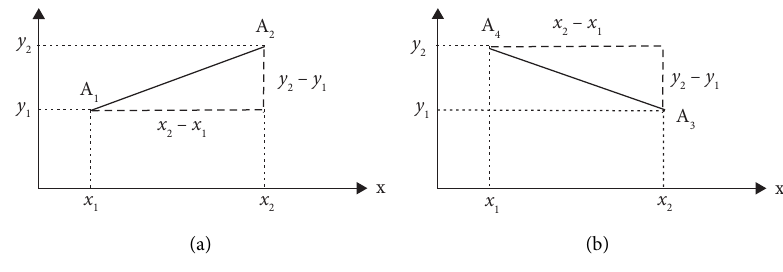
Figure 1: Mutual interchange property of